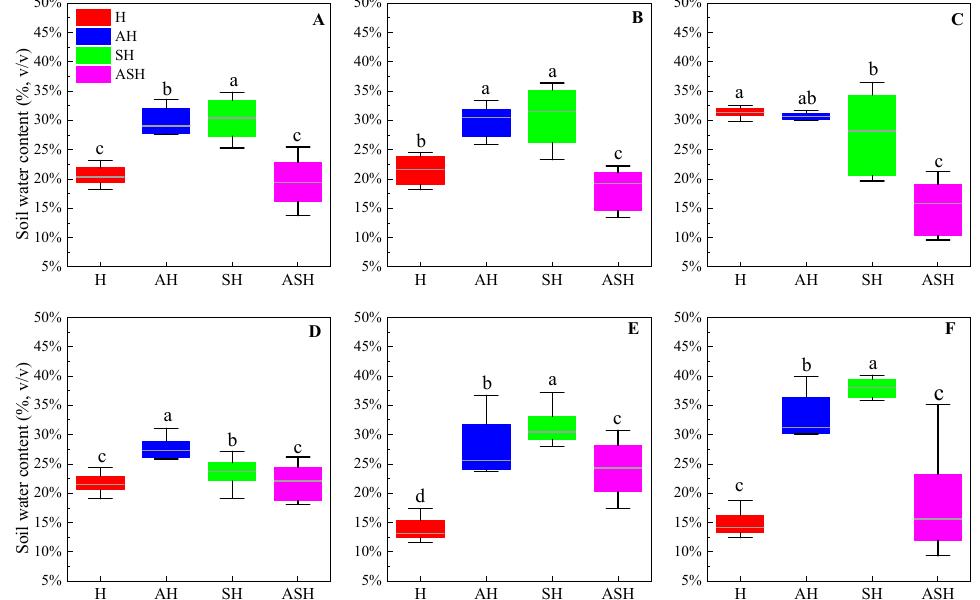
Figure 3. Comparison of soil water content for 0–70 cm. ( A ) 0–70 cm, ( B ) 0–10 cm, ( C ) 10–20 cm, ( D ) 20–30 cm, ( E ) 30–50 cm, ( F ) 50–70 cm. Different lowercase letters indicate significant differences of soil water content in the different plant community structure types of the same soil layer ( p < 0.05) ．